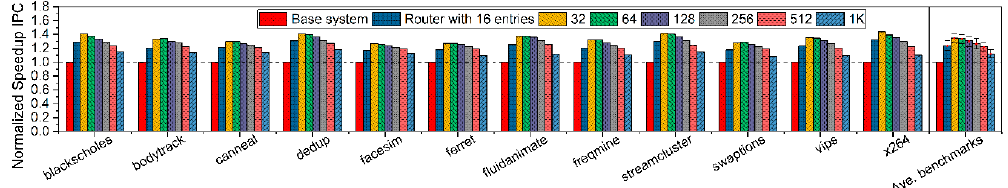
Figure 10. Normalized IPC values of proposed router-integrated system with different history buffer scales ranging from 16 to 1K entries.